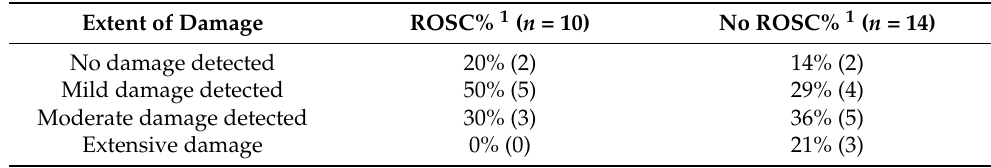
Table 1. Electron microscopy qualitative percentage of ultrastructural damage and lesions, as ob- served in both